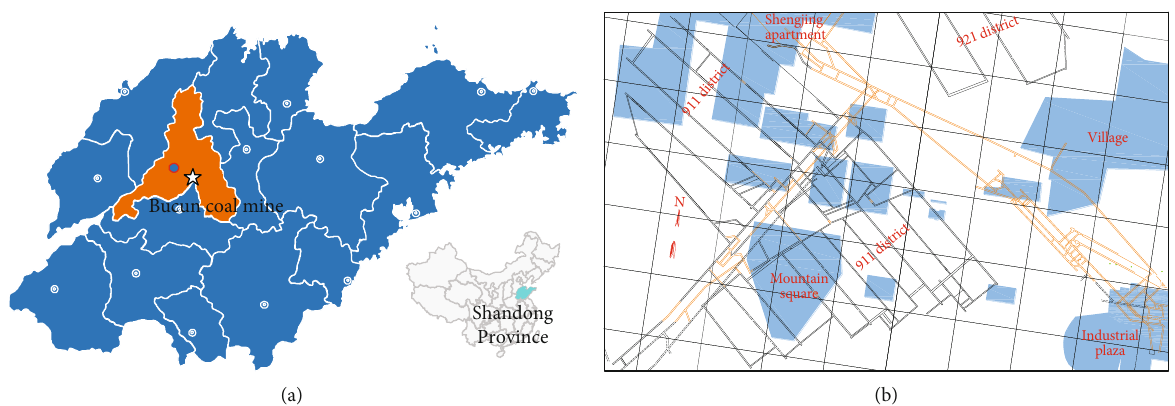
Figure 1: Bucun coal mine geographic information map: (a) location of Bucun coal mine; (b) location of the down hole working face and surface